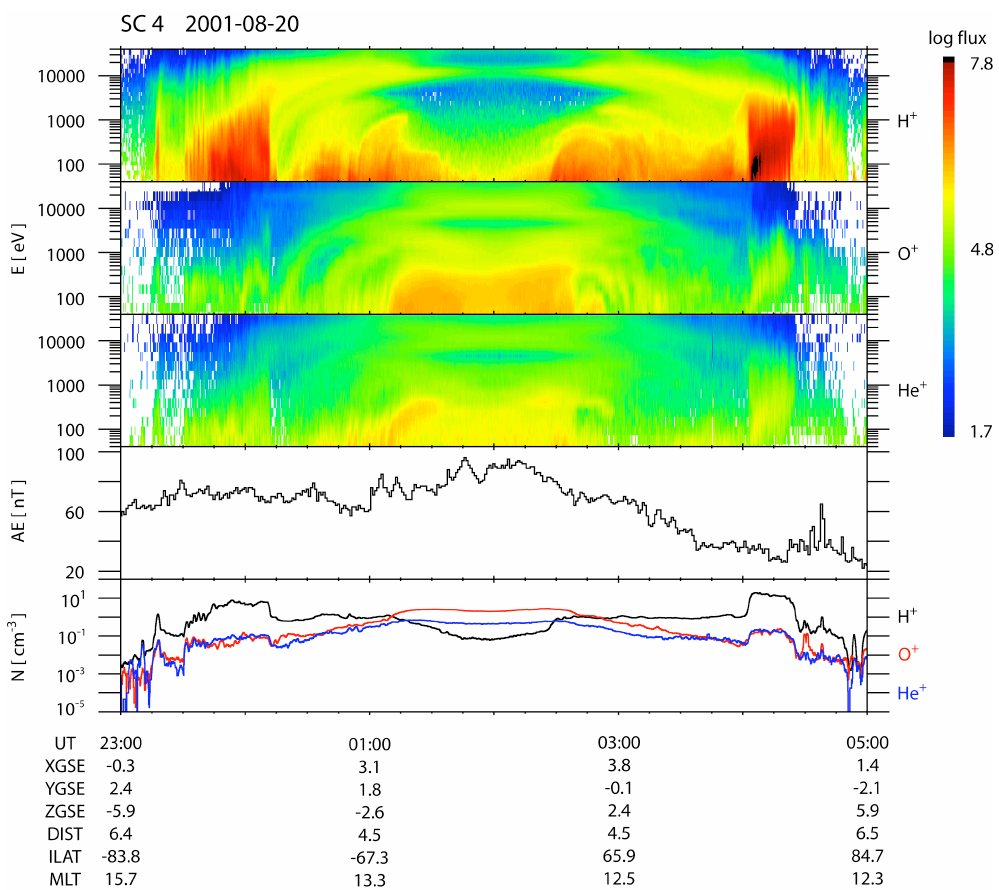
Figure 1: Energy-time spectrograms in [(cm 2 s sr) -1 ], AE and density plot of H + , O + and He + Fig. 1. Energy-time spectrograms over 4 π average differential fluxes in [(cm 2 ssrkeV) − 1 ], AE and density plot of H + , O + and He + in the energy range of 0.04keV to 40keV for the entire pericentre pass of the 20–21 August 2001. in the energy range of 0.04 keV to 40 keV for the entire pericentre pass of the August 20 - 21, related to past substorm activities many hours before. 2001.